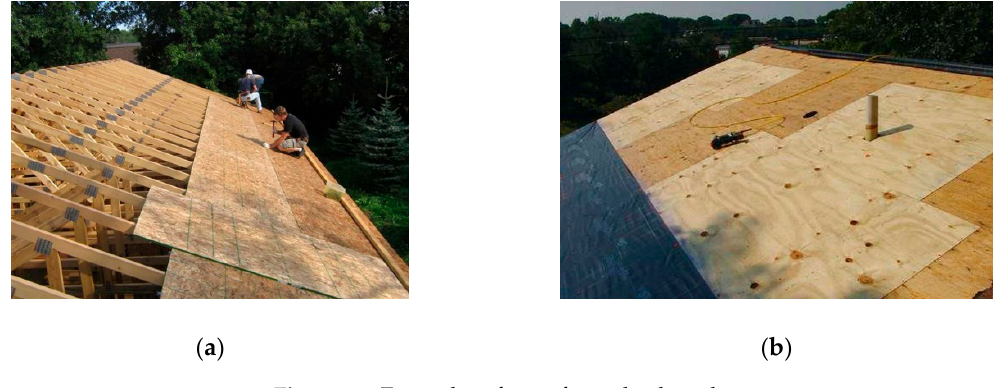
Figure 30. Examples of use of wooden boards.